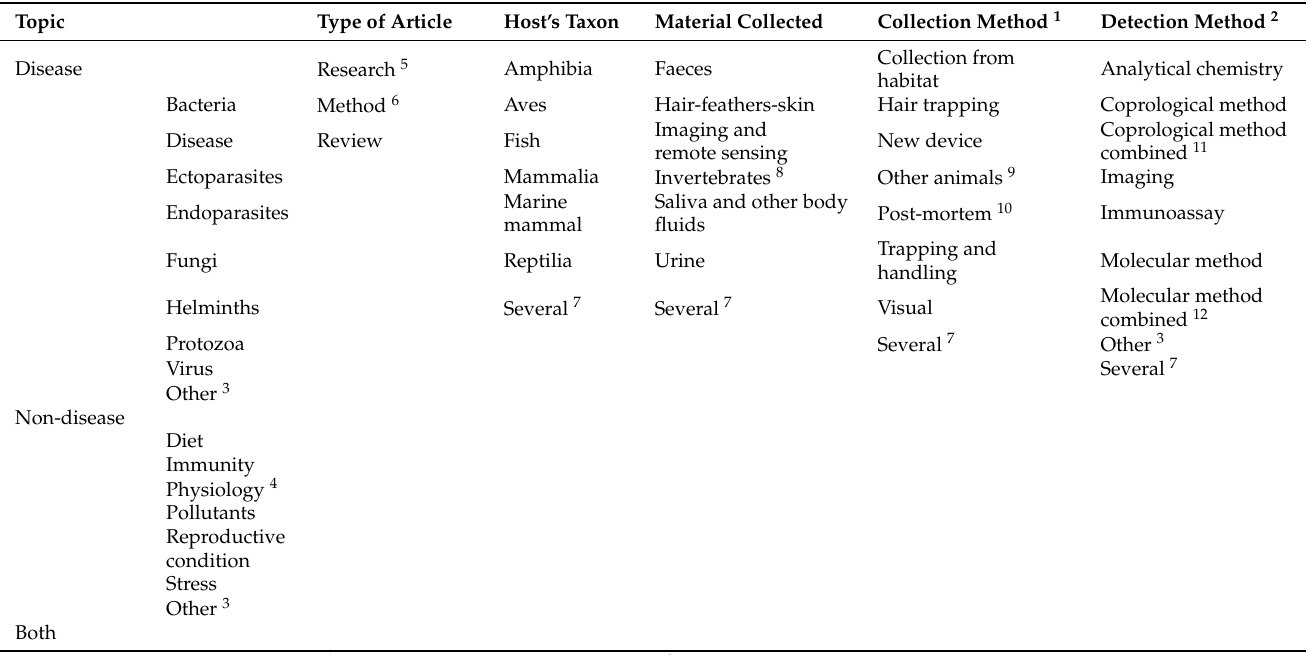
Table 1. The categories used to classify articles included in the present